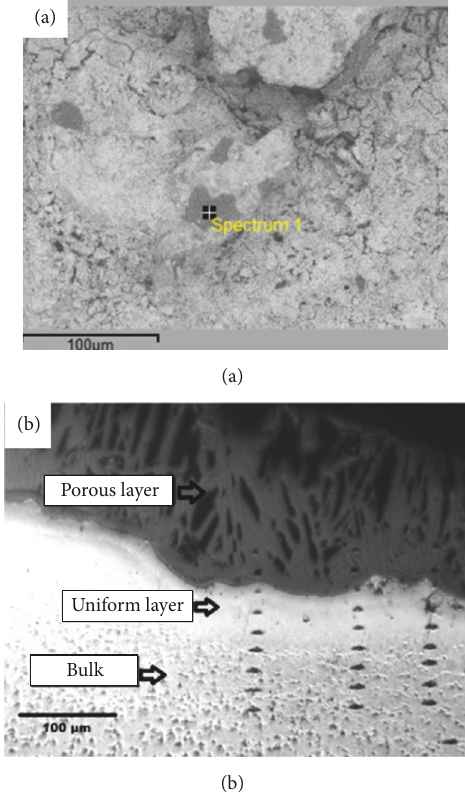
Figure 19: SEM micrograph: (a) Ti-6Al-4V after calcium deposition by AM-EDM; (b) uniformly distributed porous layers.